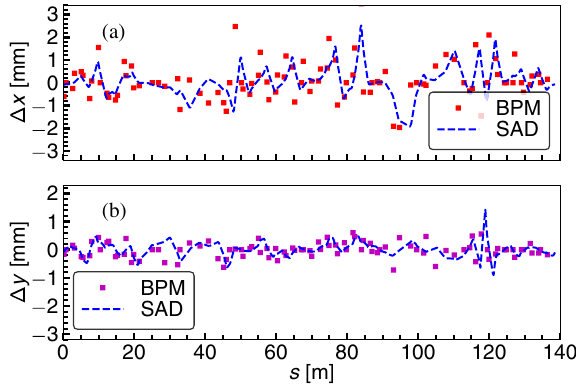
FIG. 2. Horizontal (a) and vertical (b) COD measured by BPMs in January 2017 and approached by local orbit bumps.